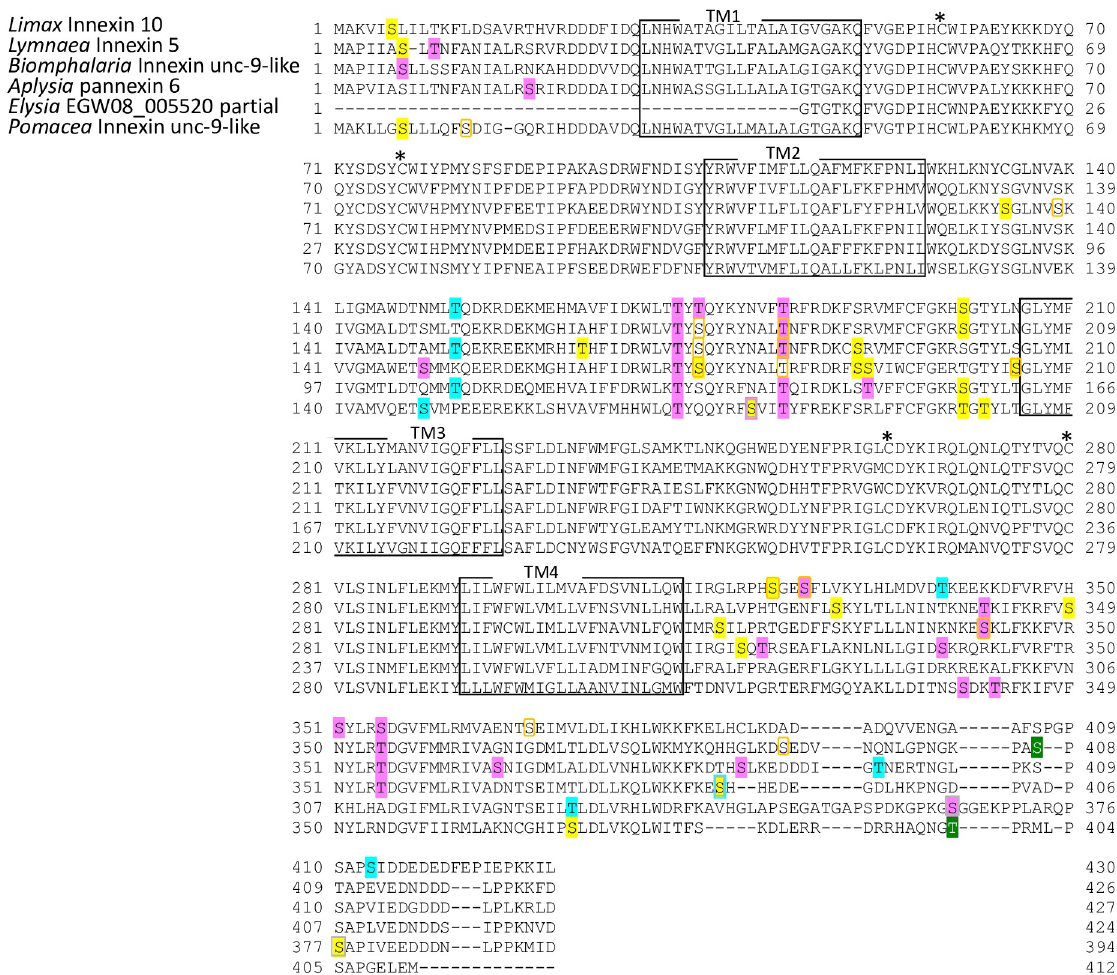
Fig 7. Protein sequence alignment of molluscan innexin orthologs in Group 5. Alignment of deduced amino acid sequences of Limax innexin 8 and 9 with orthologous innexin sequences. The boxes show the four transmembrane domains, while the asterisks indicate the extracellular cysteine residues. The potential S-nitrosylation sites are shaded in black. The phosphorylation sites are indicated with shading or box in magenta (protein kinase C), yellow (protein kinase A), blue (casein kinase 1), cyan (casein kinase 2), green (p38-mitogen-activated protein kinase), and gray (protein kinase G). Potential N-glycosylation sites are underlined with bold red lines.